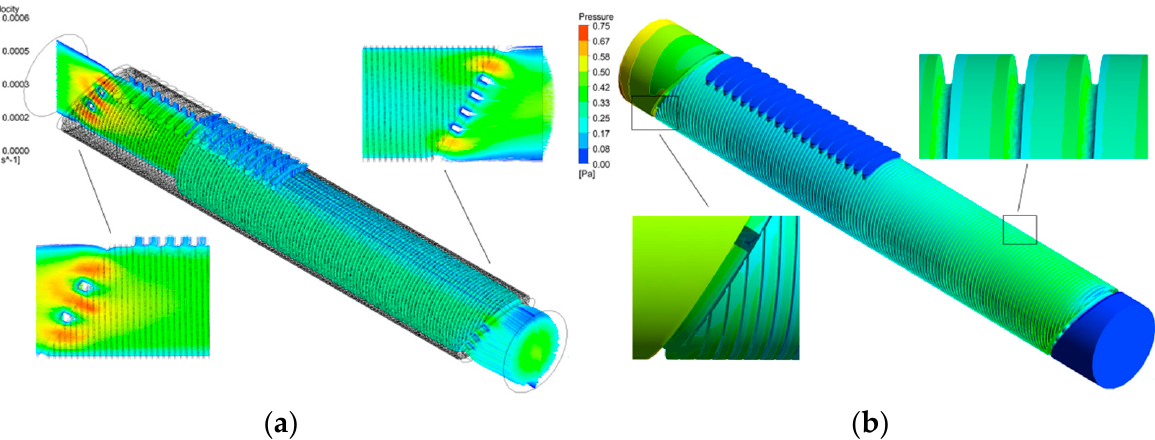
Figure 6. Velocity and pressure distributions inside the xylem vessel: ( a ) velocity distribution of the vessel; ( b ) pressure distribution of the vessel.